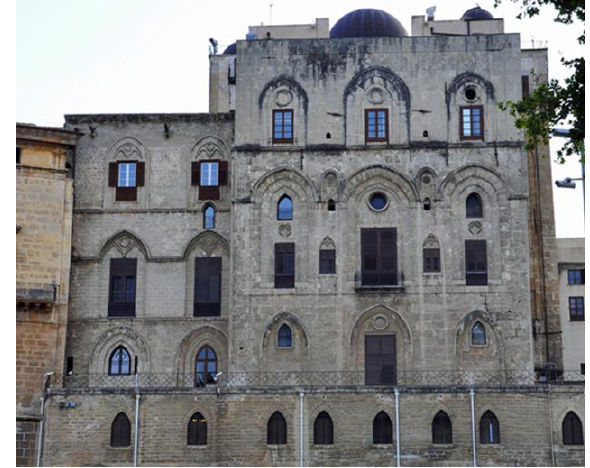
Figure 7. The Pisana Tower in Palermo (ph. R.